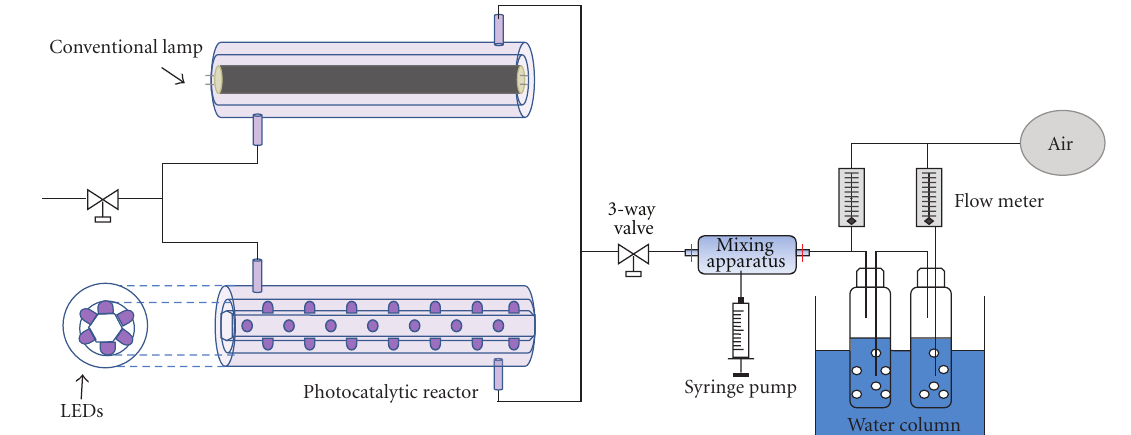
Figure 1: Schematic diagram of the experimental setup.